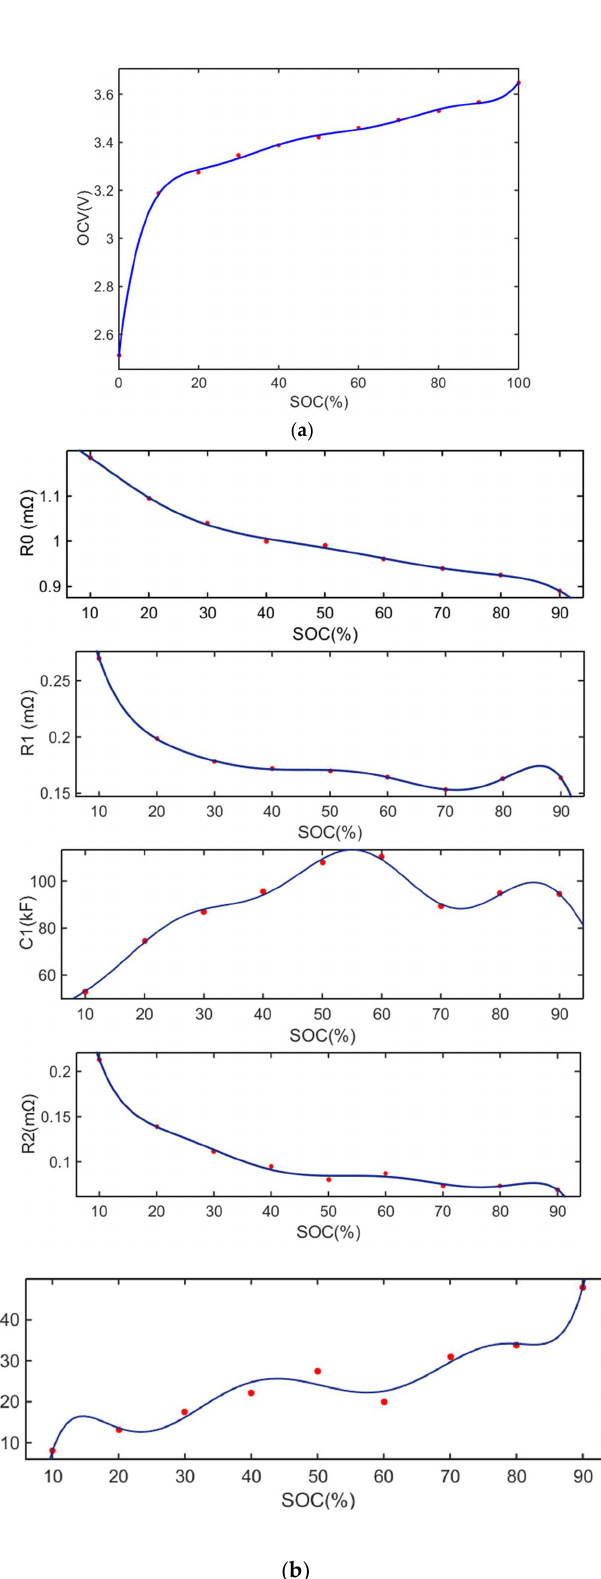
Figure 6. ( a ) Relationship between OCV and SOC of battery. ( b ) Parameters of battery equivalent circuit model and its fitting curve.